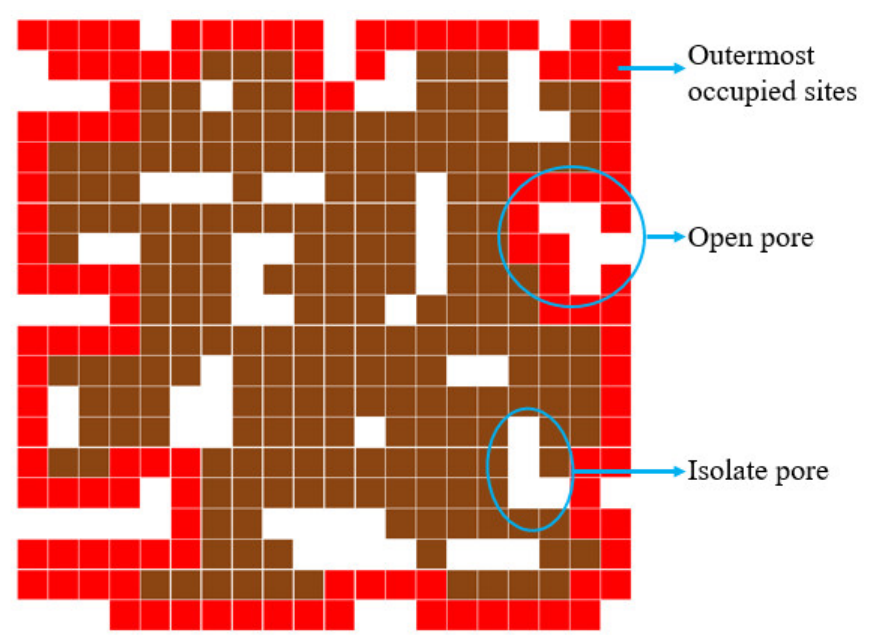
Figure 1. Char matrix and outermost occupied